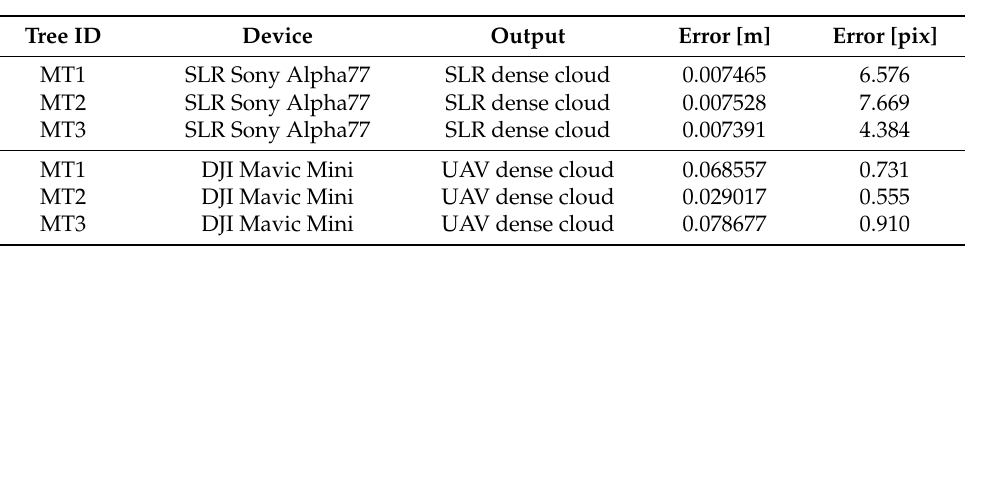
Table 1. SfM errors in both meters and pixels for the three monumental tree surveys using UAV and SLR